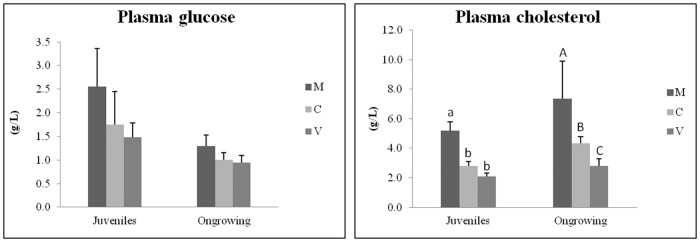
Plasma metabolites in juveniles and ongrowing fish (g/L).Data are means ± standard deviation (n = 16 individuals /dietary treatment for juveniles; n = 15 individuals/dietary treatment for ongrowing fish). Differences between diets were analyzed by one-way ANOVA, followed by Tukey’s test. Values that do not share a common letter are significantly different (p<0.05), with lower and upper case letters indicating differences between dietary groups within juveniles and ongrowing fish, respectively.